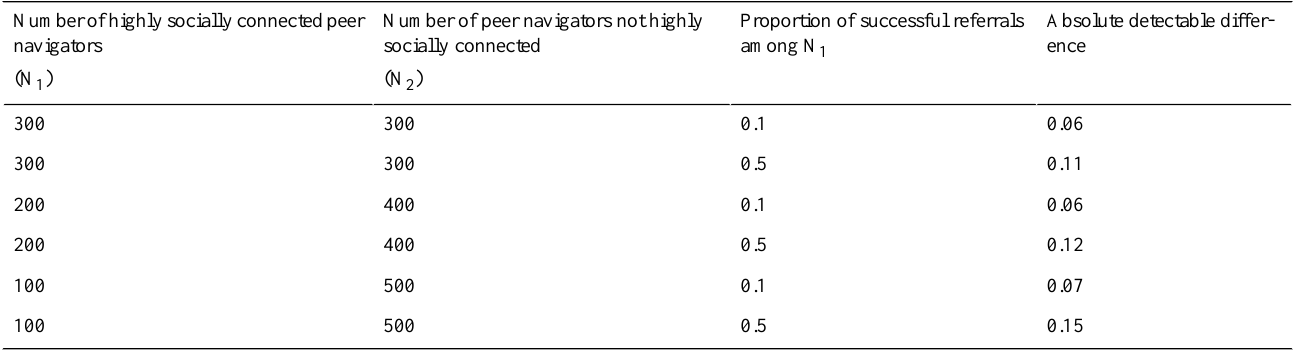
Table 2. Power calculations for comparing the association of referral success and social